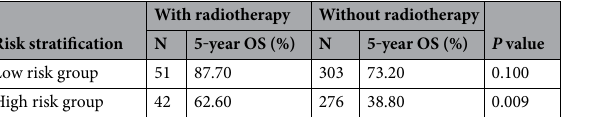
Table 4. Survival analysis of patients stratified to two different risk groups. N number, OS overall survival.